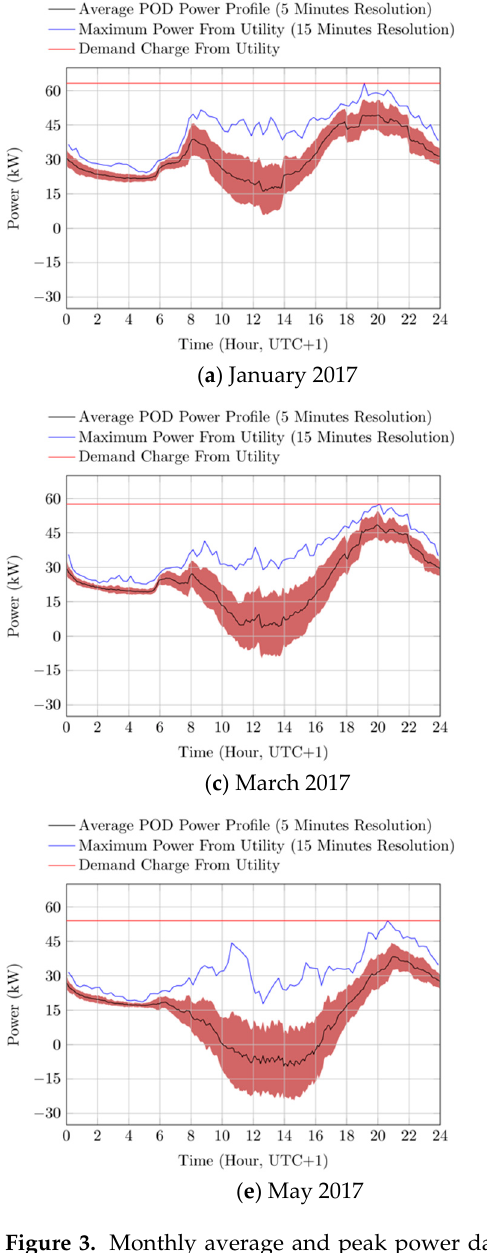
Figure 3. Monthly average and peak power data of the user’s point of delivery (POD), recorded from January to June 2017, as depicted from sub-figure ( a ) to sub-figure ( f ), respectively. Positive and negative values represent power flows from the grid and to the grid, respectively. Data are sampled every 10 s and the averages are recorded every 5 min. The red area represents the standard deviation of the measured POD power flows. UTC: Universal Time Coordinated.